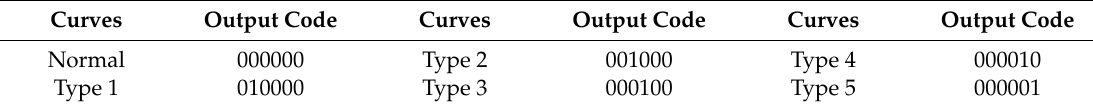
Table 2. The way of one-hot coding for power